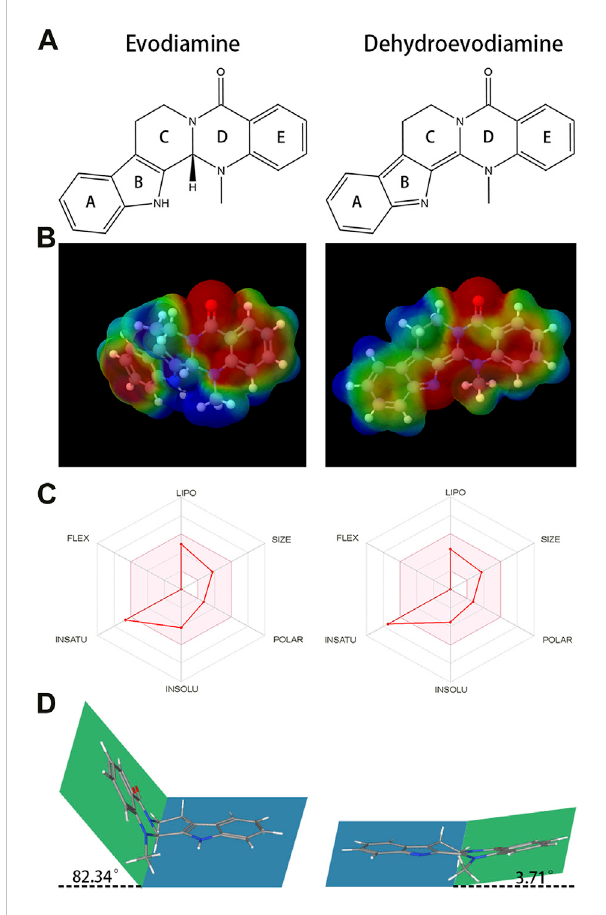
FIGURE 1 The chemical structures and Molecular electrostatic potential (MEP) of evodiamine (EDM) and dehydroevodiamine (DEDM). (A) The chemical structures of evodiamine (EDM) and dehydroevodiamine (DEDM). (B) Molecular electrostatic potential (MEP) of EDM and DEDM. Different colors, i.e., Blue, Red, Green, Light Blue, and Light yellow represent the scale of MEP for electron-rich, partial negative charge; electron-de fi cient, partial positive charge; neutral, uncharged; slightly electron-rich; and slightly electron-de fi cient respectively. (C) Bioavailability Radar of (EDM) and (DEDM). Bioavailability Radar is shown for rapid assessment of drug-likeness. The optimal range for each property is represented by the pink area. Lipophilicity = XLOGP3 +5.0 and − 0.7; size = MW between 150 – 500 g/mol; polarity = TPSA between 20 – 130 Å 2 ; solubility = log S j 6,saturation=fractionofcarbonsinsp 3 hybridization > 0.25,and fl exibility = rotatable bonds should not be more than nine. (D) . The stereostructure of EDM and DEDM (Blue and green represent the two planes of the alkaloid ’ s stereo structure. Rings A, B and C in the blue plane, ringsD and E in the green plane. The dihedral angle is 82.34 ° for EDM and 3.71 ° for